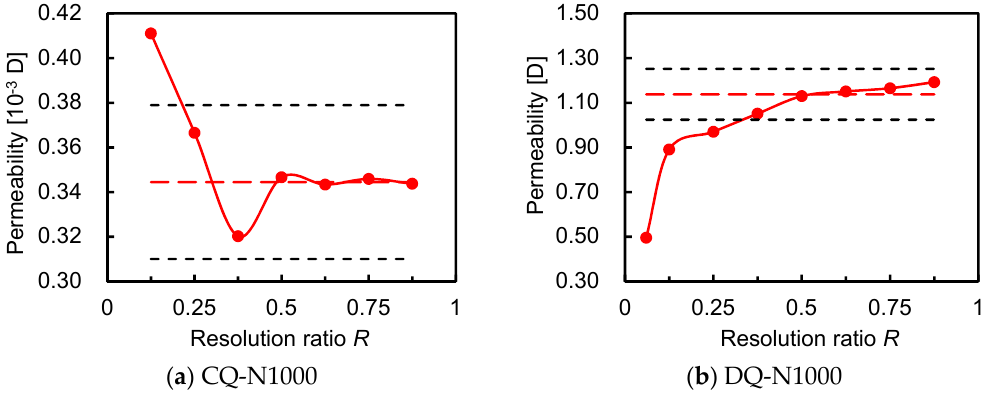
Figure 8. Resolution effect on calculated permeability at N = 1000 sample size. Red long-dashed line is the estimated mean permeability and two black short-dashed lines cover 10% variation from the mean permeability.